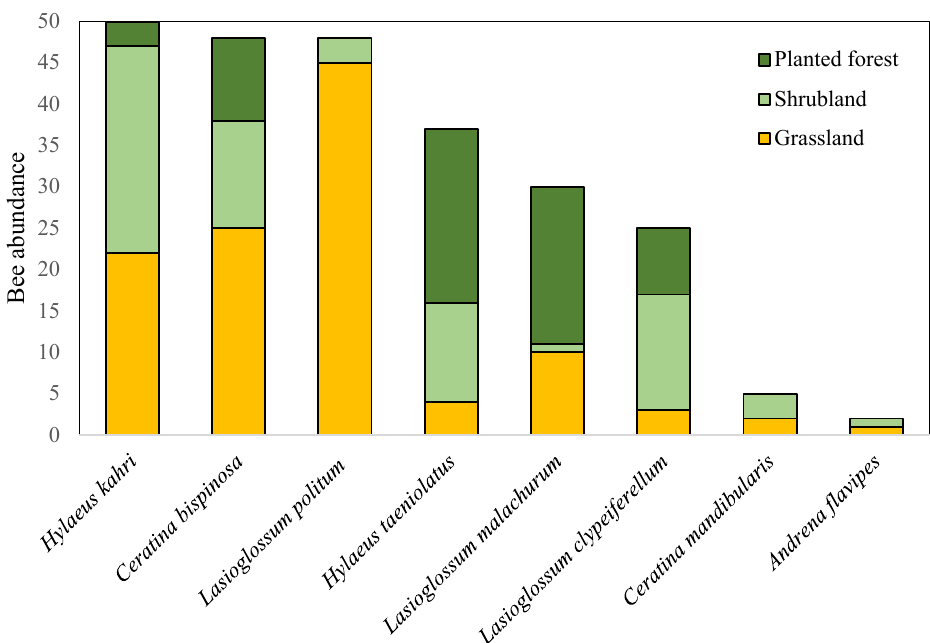
Figure 6. Crop pollinator abundance in the different uncultivated